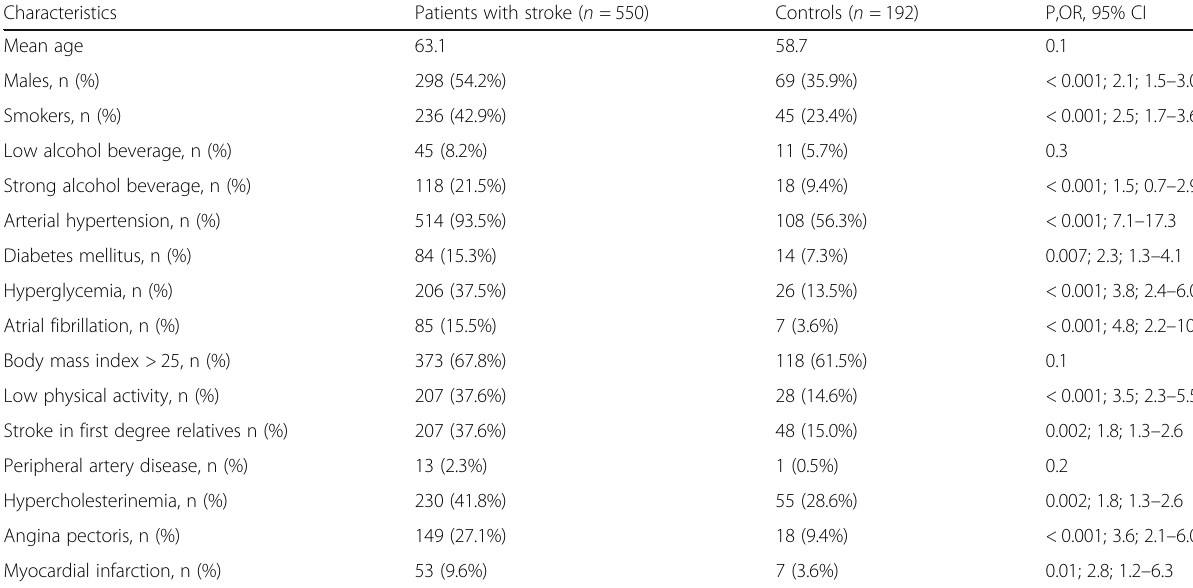
Table 1 Clinical characteristics of patients with stroke compare to controls Characteristics